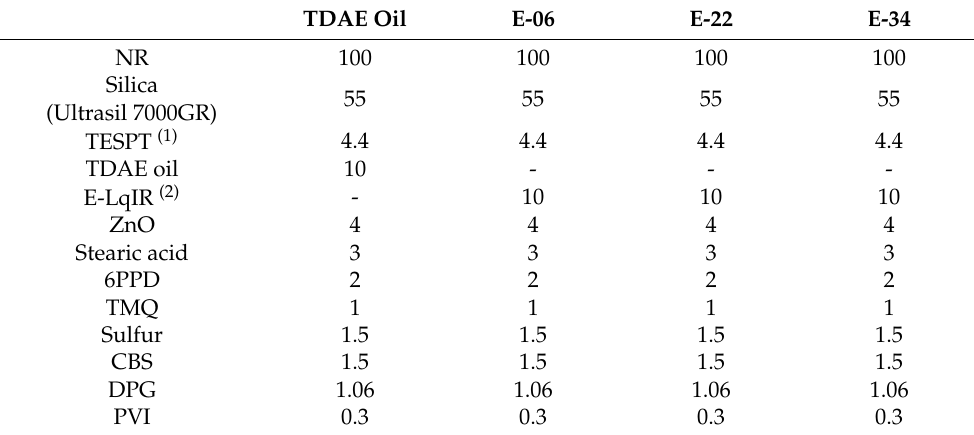
Table 1. Formulation of the NR/silica compounds using processing aids (unit: phr).